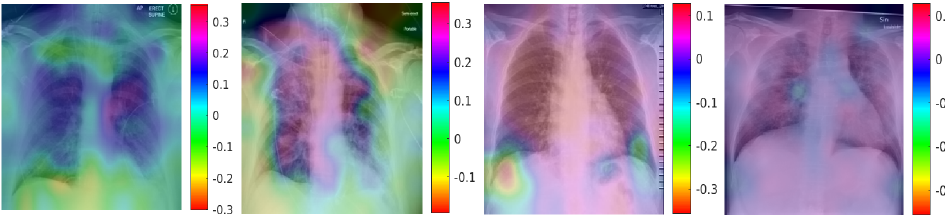
Figure 13. ROI for Normal cases using ACM.